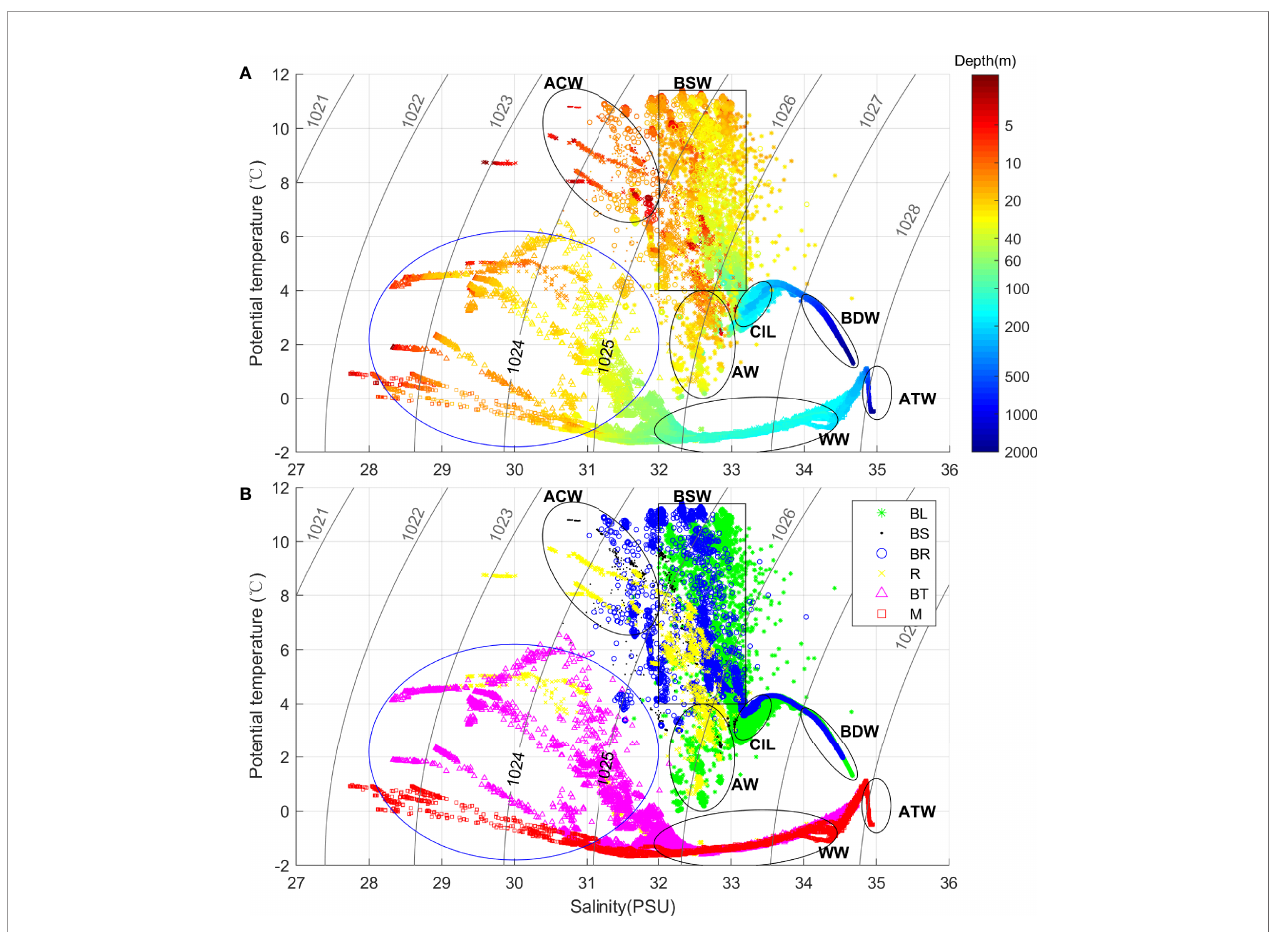
FIGURE 2 | T-S diagram shows distinct water masses in the Bering Sea and Chukchi Sea based on CTD observations. (A) The color represents depth. (B) The color represents different areas. AW, Anadyr Water; ACW, Alaska Coastal Water; BDW, Bering Sea Deep Water; BSW, Bering Sea Shelf Water; CIL, Cold Intermediate Layer; WW, Winter Water; ATW, Atlantic Water. The blue circle represents the water masses in the Chukchi Sea except